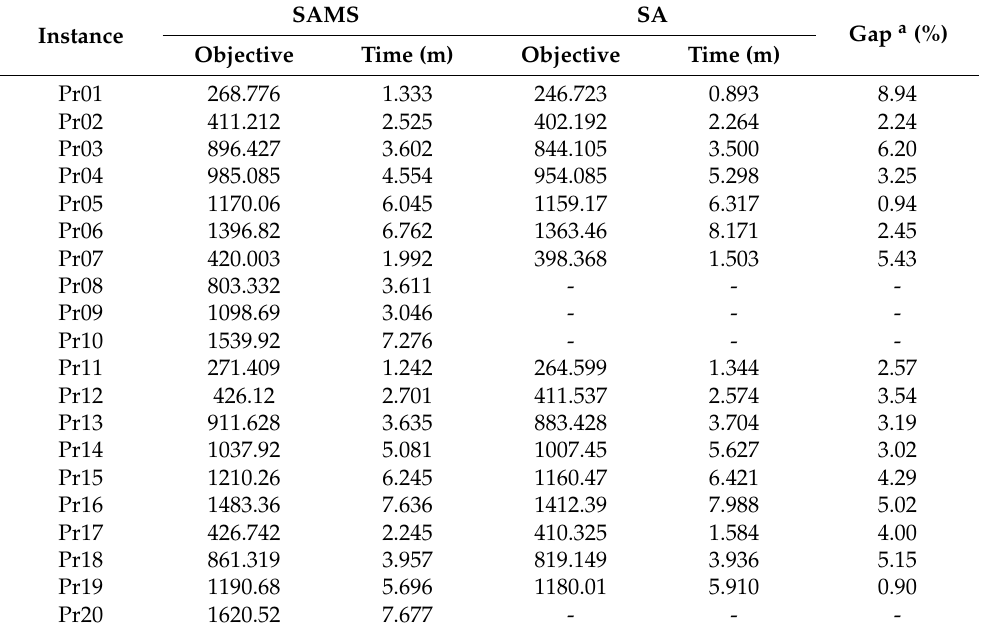
Table 4. Comparison between basic SA and proposed SAMS solution for SARPFC large instance. Instance